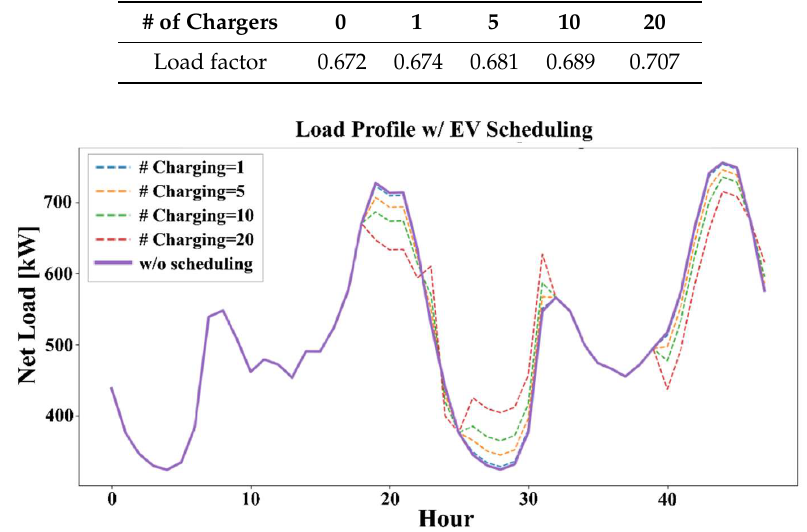
Table 3. Calculated load factor according to the number of chargers. 444